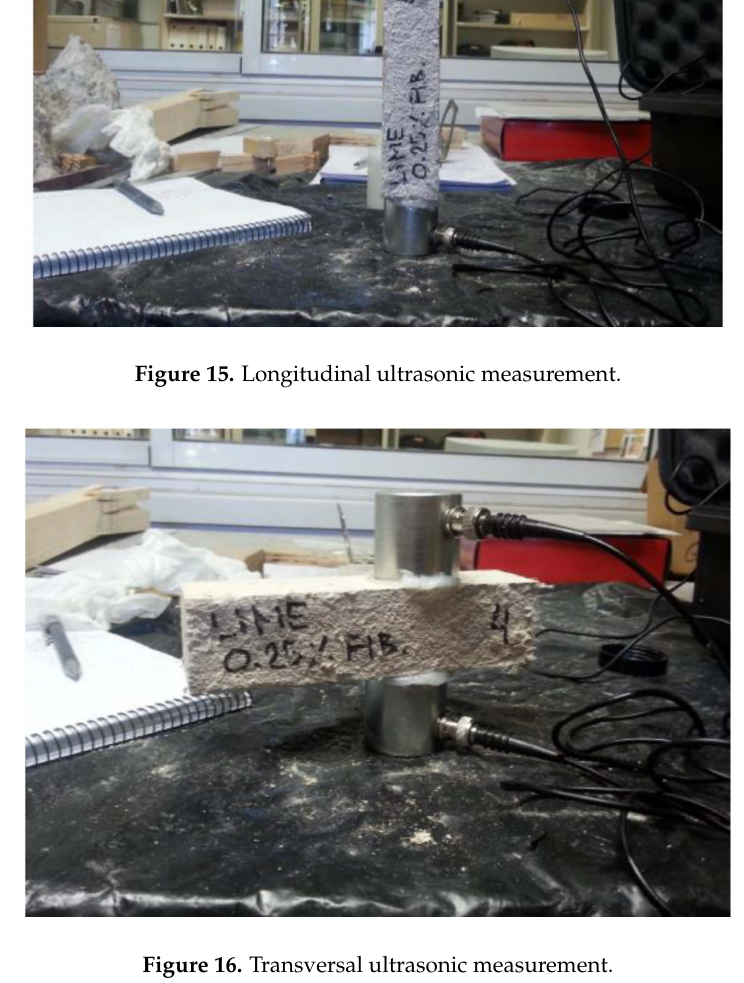
Figure 16. Transversal ultrasonic